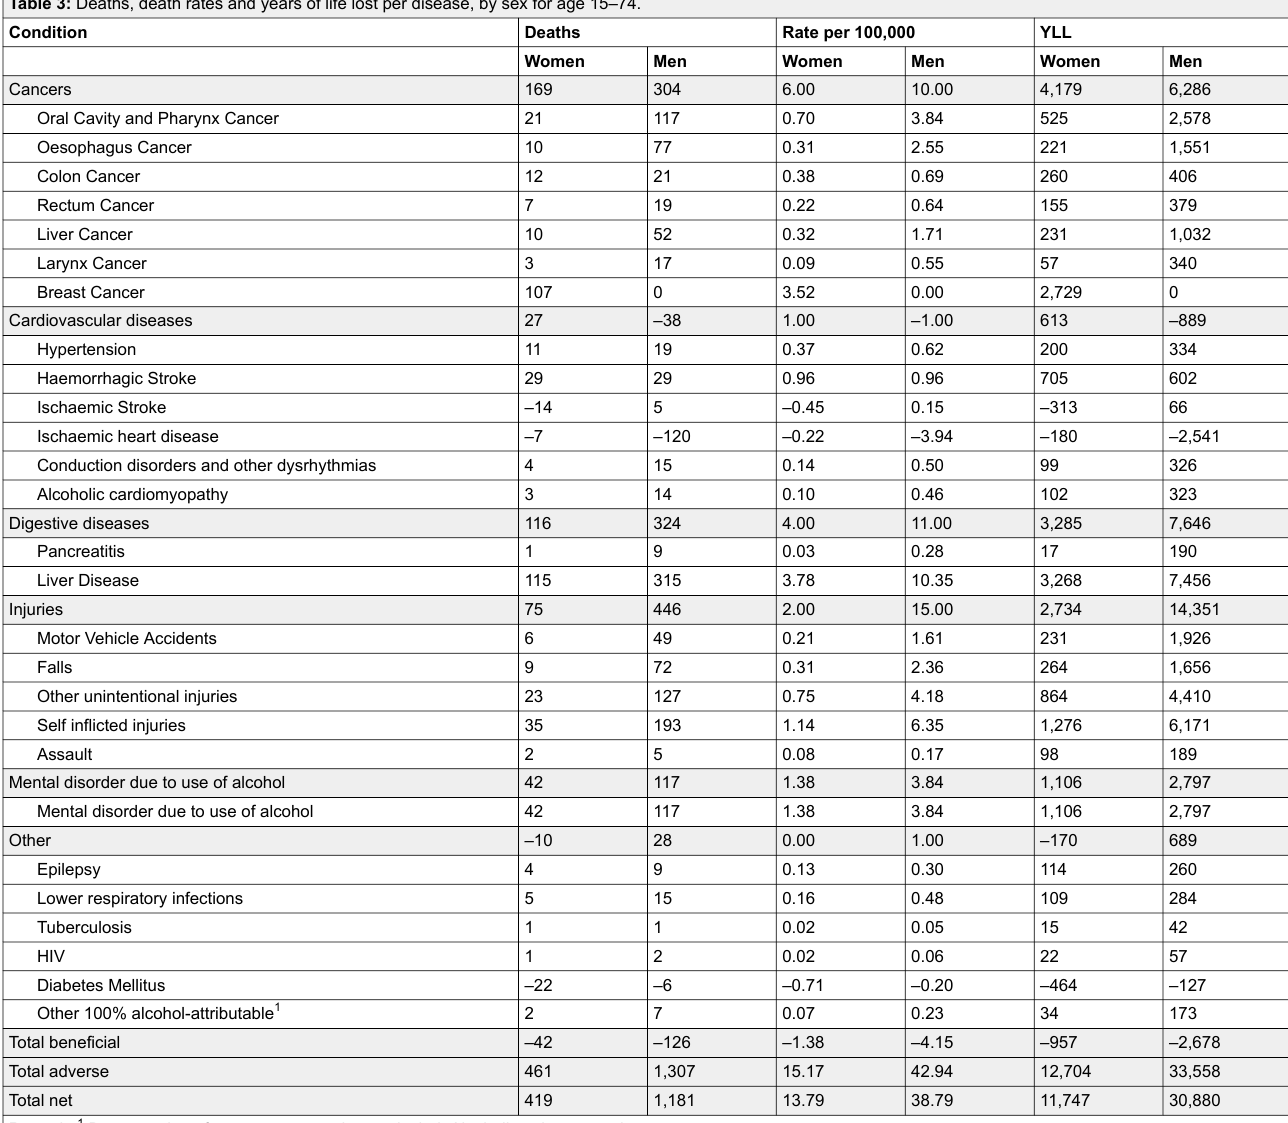
Table 3: Deaths, death rates and years of life lost per disease, by sex for age 15–74.